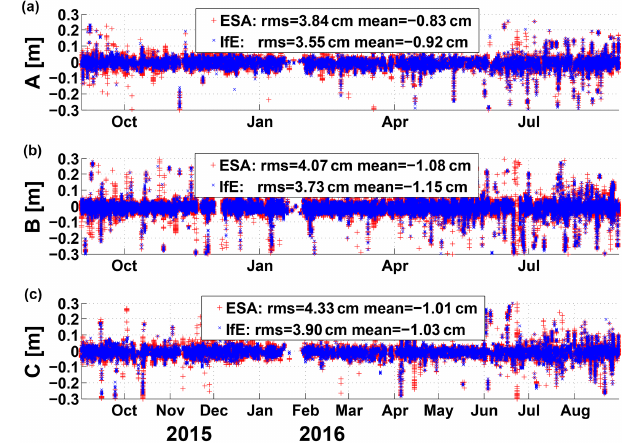
Figure 14. SLR residuals over 1 year from DoY 245, 2015 to 244, 2016, for (a) Swarm A, (b) B and (c) C. The residuals for IfE are given in blue and ESA kinematic orbits in